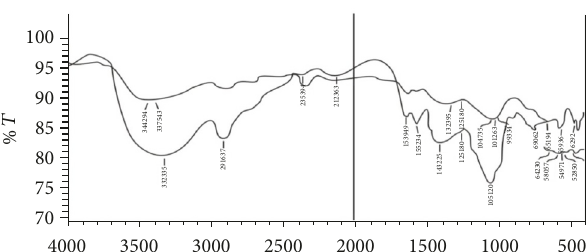
Figure 3: Representative FT-IR graphs of ENa and AANa (compar- ison).